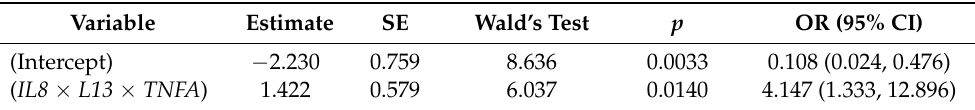
Table 7. The parameters of the best-fitting logistic regression model for predicting postpartum AGT in GDM patients (NGT, n = 18; AGT, n = 10). Variable Estimate SE Wald’s Test p OR (95% CI) (Intercept) −